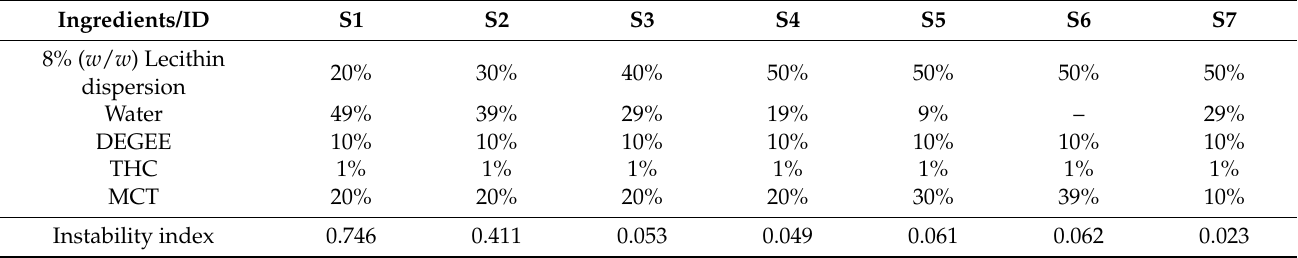
Figure 7. As the data indicated, nanoemulsion F1 was stable with no noticeable particle size change. Visual inspection was also conducted, which confirmed that there was no visible phase separation, oil agglomeration, etc., for F1 at the end of one month under both storage conditions. Table 3. Compositions of the formulations for initial screening and the results of the instability index from LUMiSizer ® .